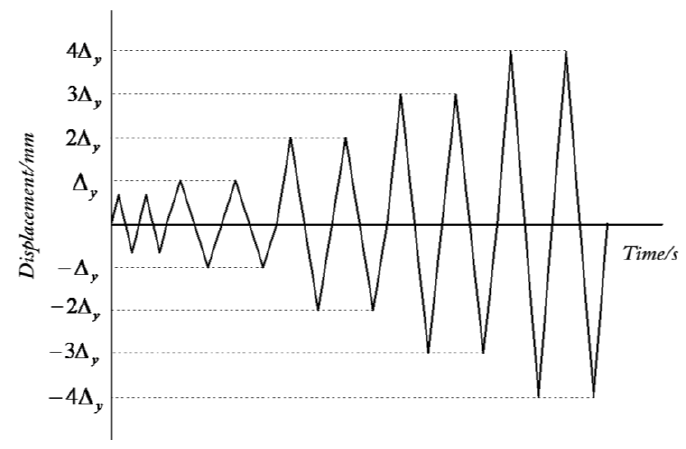
Figure 5. The loading